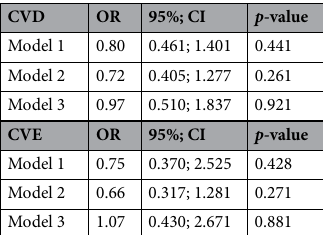
Table 1. Association of sCAIX with prevalent CVD and CVE. Logistic regression analysis using 572 participants for model 1 and 2, 560 participants for model 3, s packyears had 12 missing values. sCAIX was treated as dichotomous independent variable (detectable yes/no, yes, n = 80). Model 1: Crude, no adjustments. Model 2: model 1 + adjustment for sex and age. Model 3: model 2 + adjustments for smoking (status [current, former, never] & packyears), medication (lipid-modifying y/n, anti-HT y/n, glucose-lowering y/n), glucose metabolism status (IGM y/n, DM2 y/n).